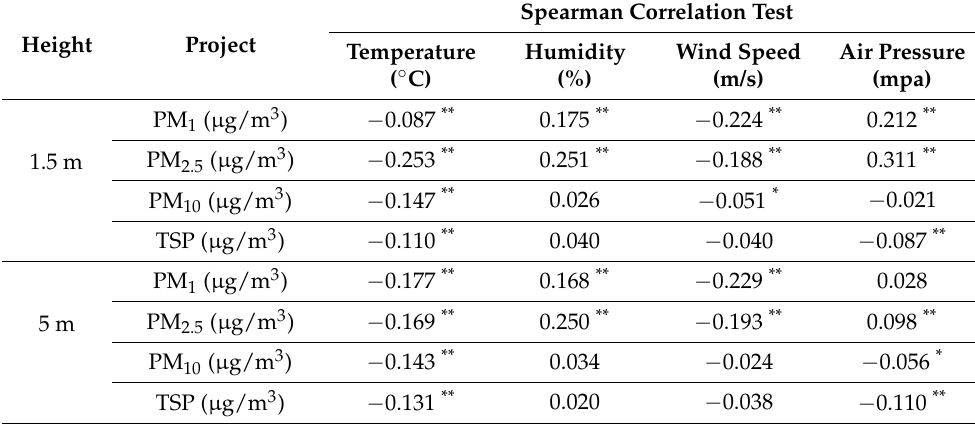
Table 3. Correlation analysis of meteorological parameters and airborne particulate matter concentrations. Height Project